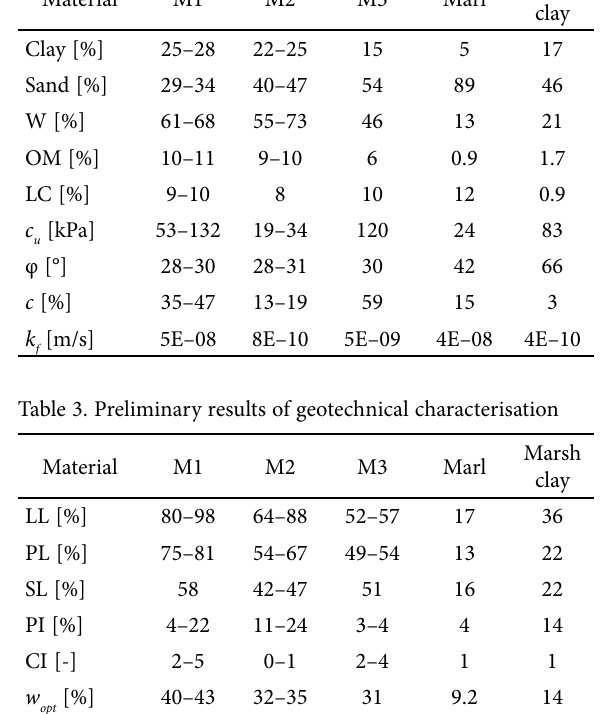
Table 2. Reliable results of geotechnical characterisation Material